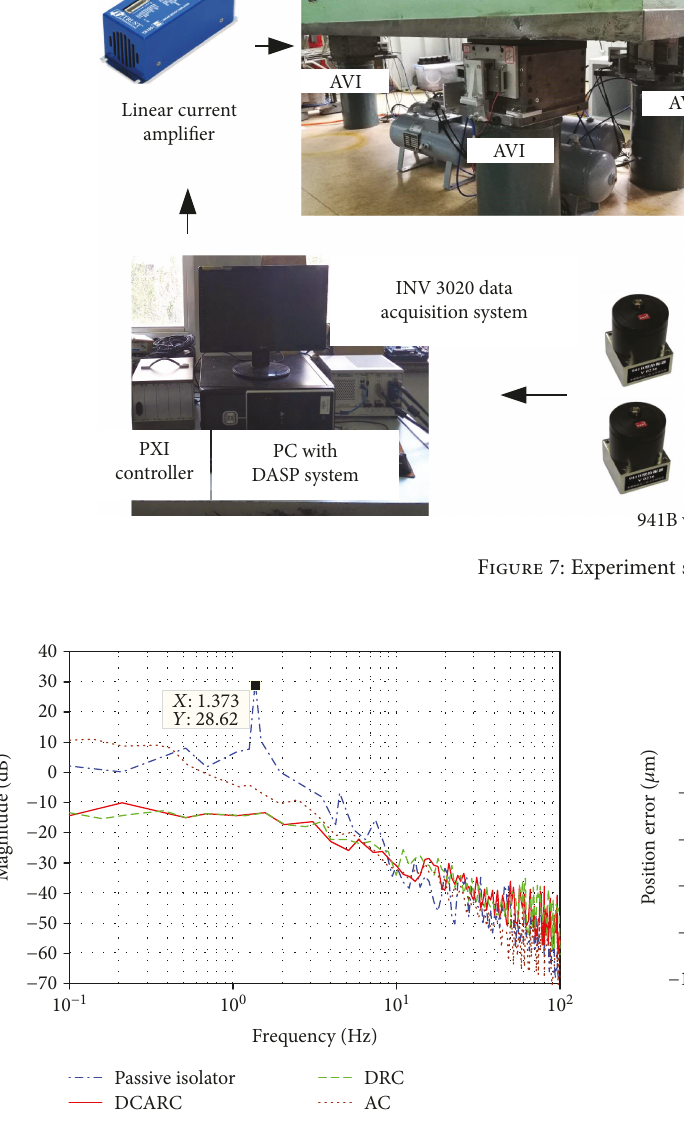
Figure 8: Measured transmissibility.